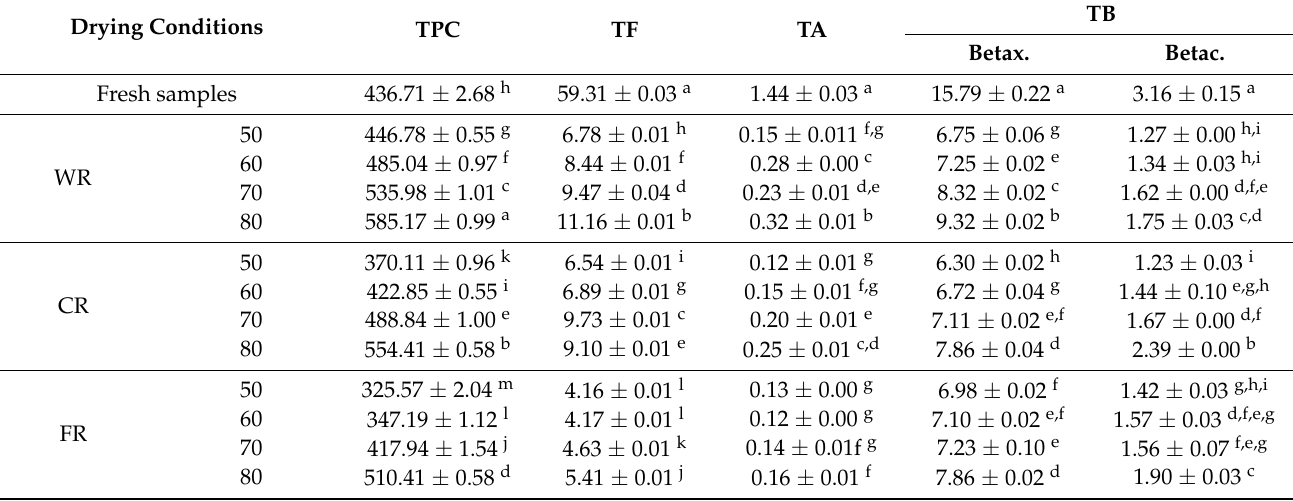
Table 4. Bioactive compounds of cumbeba residue both fresh and dried under different conditions. Drying